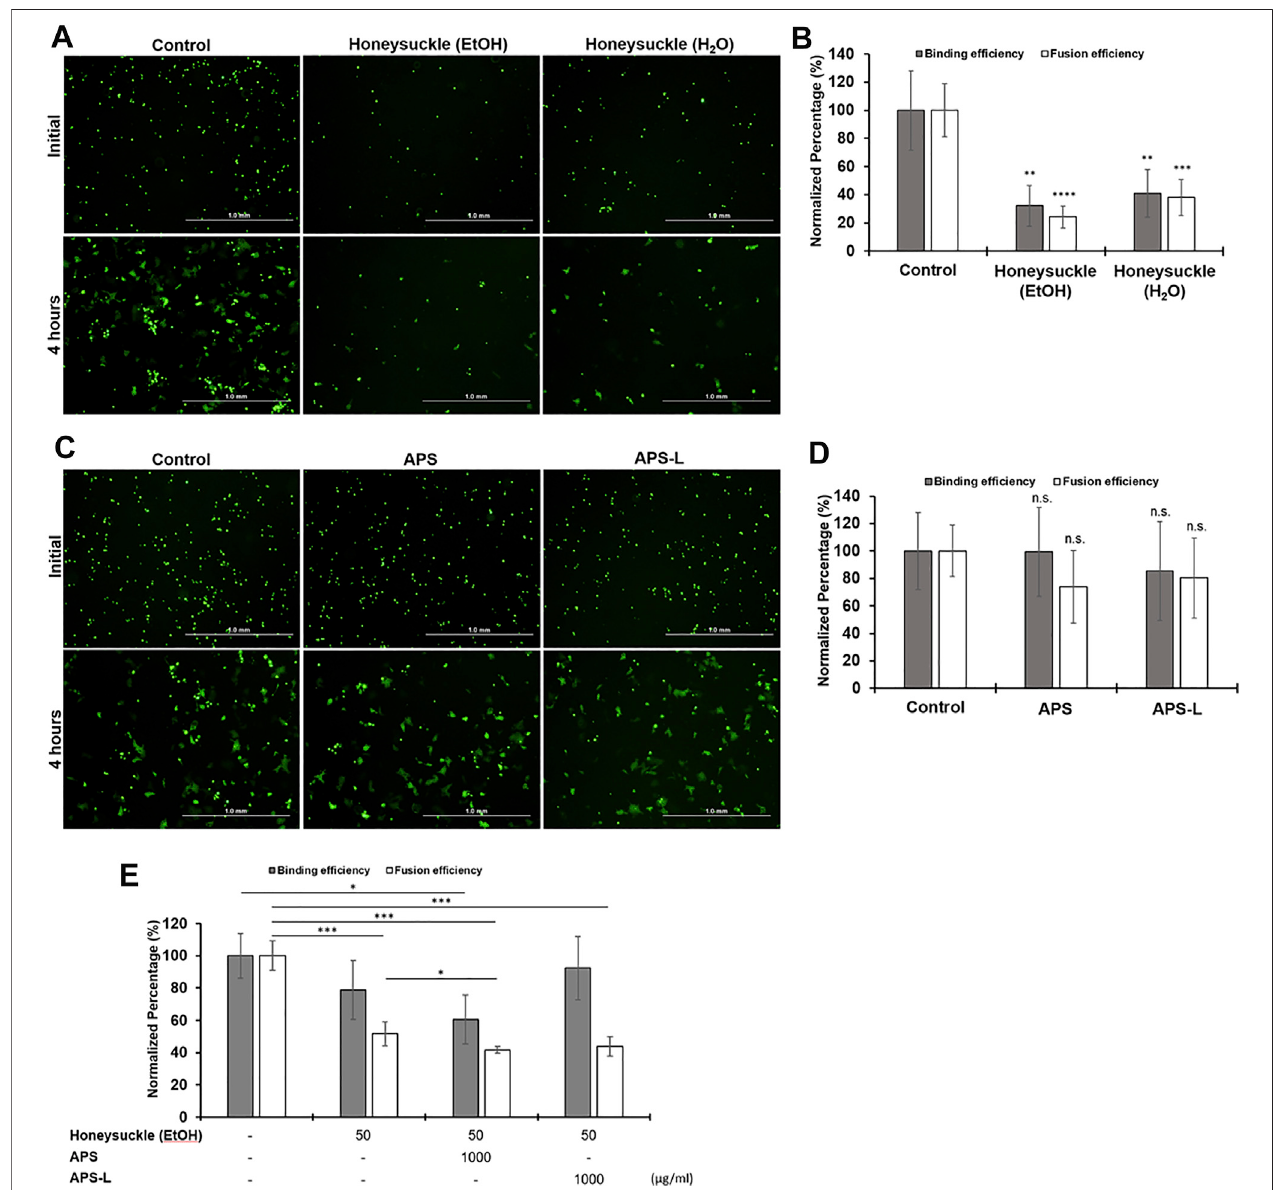
FIGURE 7 | The effect of honeysuckle, Huangqi, and their combination on the binding of SARS-CoV2-spike with ACE2 and syncytia formation. (A,C) Imaging of EGFP/spike-positiveBHK-21 effectorcellbinding(upper panel) andfusion(lower panel) withCalu-3 target cellsin theabsenceor presence ofhoneysuckle (A) ,Huangqi (C) , or combination of honeysuckle-EtOH and either APS or APS-L. The binding ef fi ciency of SARS-CoV2-spike to ACE2 (gray bars) and the formation of syncytium indicating fusion ef fi ciency (white bars) was quanti fi ed in the cells treated with honeysuckle (B) , Huangqi (D) , and honeysuckle-EtOH combined with either APS or APS-L (E) . *, p < 0.05; **, p < 0.01; ***, p < 0.001; n.s: no signi fi cance. Scale bar equals 1.0 mm in all fi